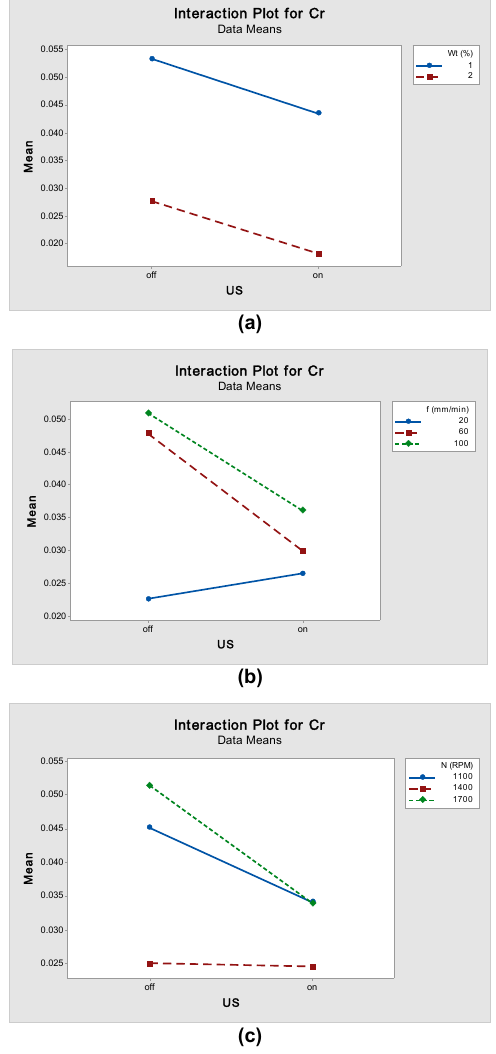
Figure 10. Interactive effect of ultrasonic (US) vibration and: (a) SiC content, (b) feed rate and (c) spindle speed; on circularity error.